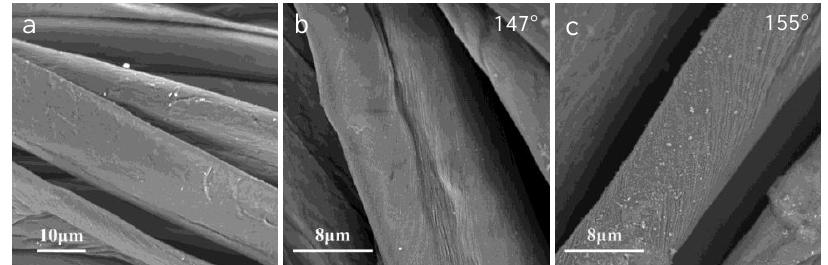
Figure 6. SEM images of samples: ( a ) untreated cotton; ( b ) N 2 plasma-treated cotton; ( c ) O 2 plasma- treated cotton.